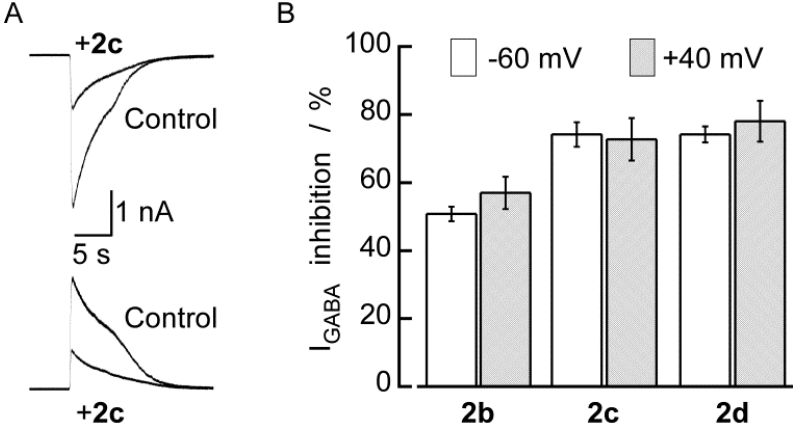
Figure 8. The inhibitory effects of compounds 2 on GABA channels were voltage A induced by 300 μ M GABA without (Control) or in presence of 2c independent. A) I GABA (100 μ M) at − 60 mV (upper traces) and +40 mV (lower traces) from the same neuron. I was recorded at 5 min intervals, and 2c was applied 3 min before the second GABA GABA application. B) The average (bars) inhibitory effect of 2b , 2c , and 2d was the same at both membrane potentials. Lines over the bars indicate the SEM.